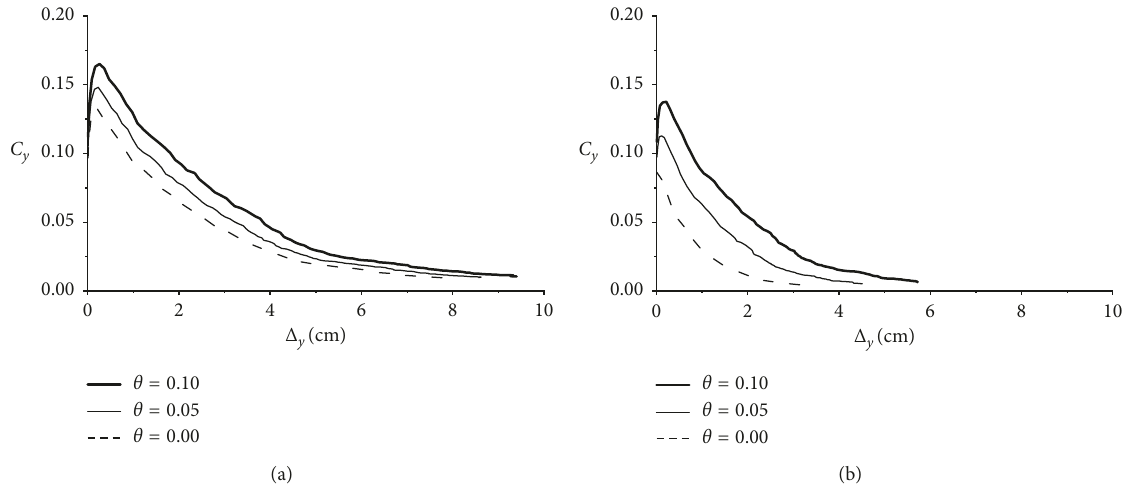
Figure 10: Normalized Δ y for four postyield stiffness ratios and soil site B considering various combinations of T and μ : (a) α (b) α � − 0.05; (c) α � 0.05; (d) α � 0.10.